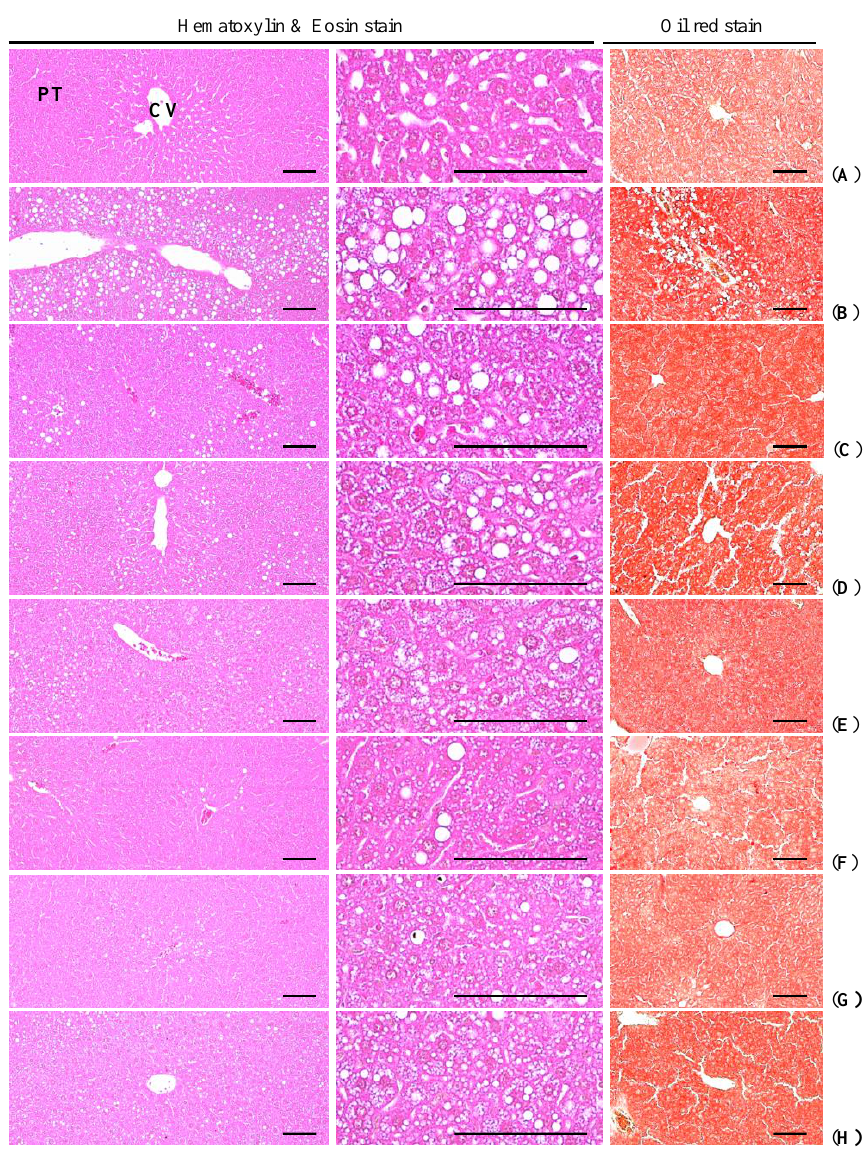
Figure 8. Representative histological images of the liver, taken from NFD or HFD supplied mice. ( A ) Intact control: Normal pellet diet supplied vehicle control mice; 10 mL/kg of distilled